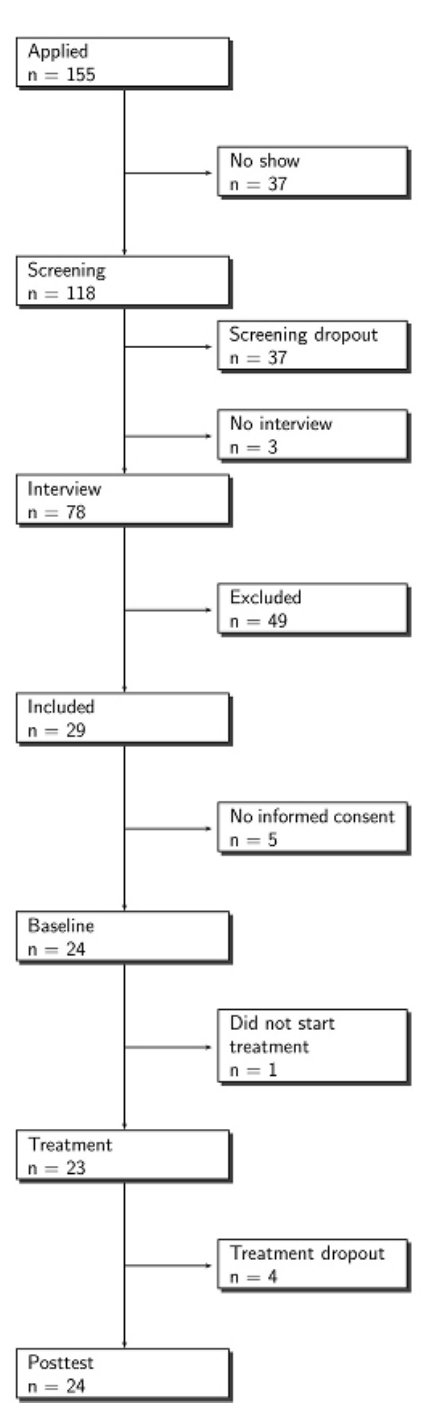
Figure 1. Flowchart of